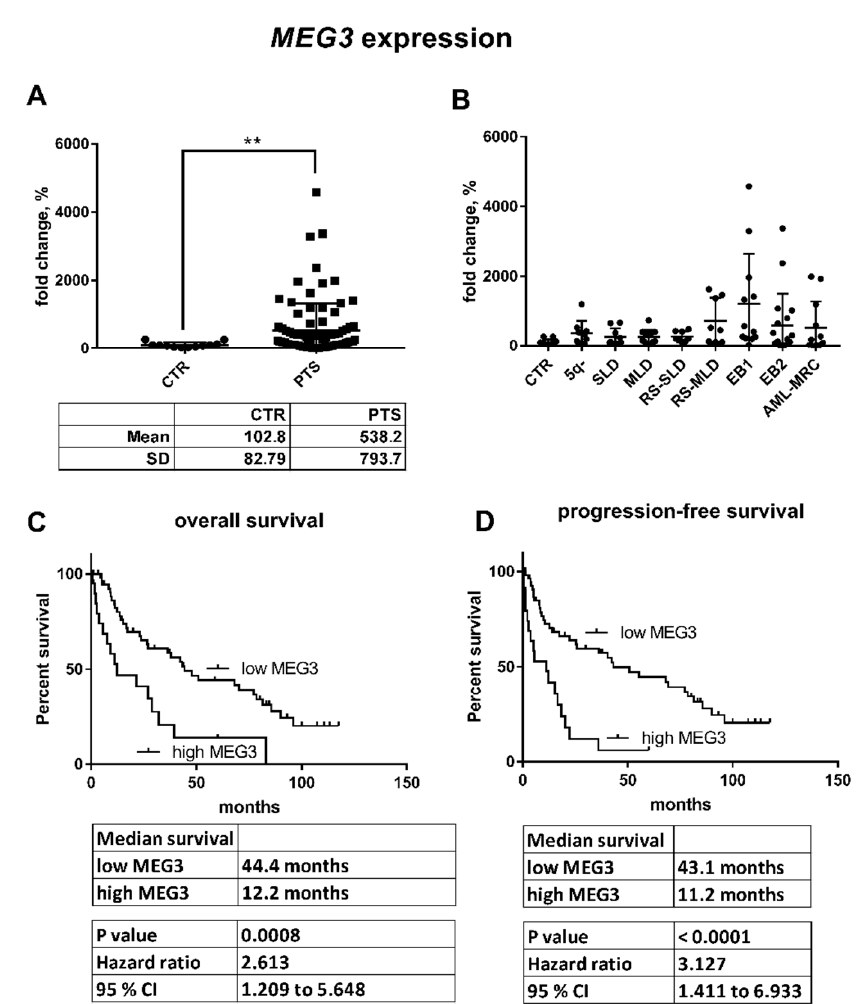
Figure 3. Relative MEG3 expression in the validation cohort of MDS/AML-MRC patients. ( A ) The expression of MEG3 was significantly different between healthy controls (CTR) and all patients (PTS) (** p < 0.01). ( B ) Further distribution of the patients according to their diagnosis revealed increased expression of MEG3 particularly in the patients with advanced disease. ( C ) Overall survival and ( D ) progression-free survival of patients with low vs. high MEG3 expression (the cut-off was set up to mean level of MEG3 ).